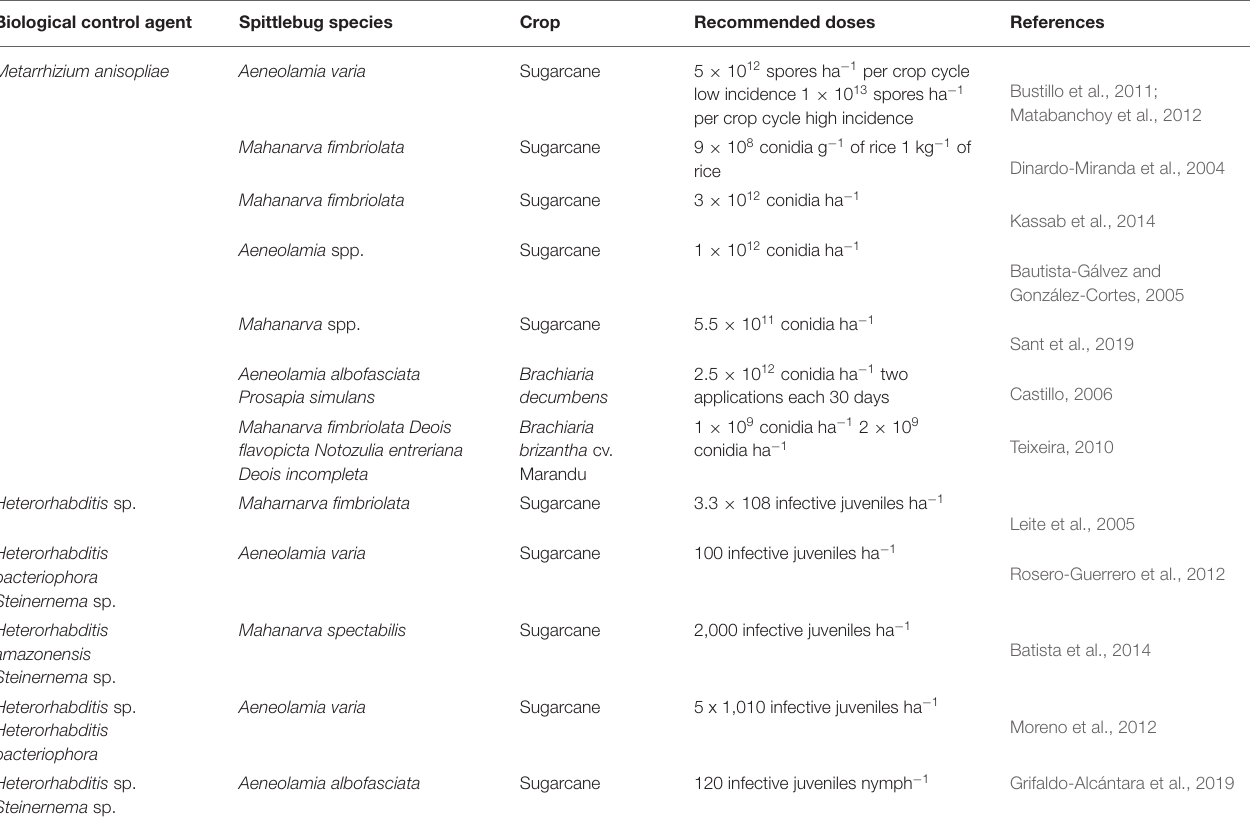
TABLE 4 | Different recommended doses of entomopathogenic fungi Metarrhizium anisopliae and nematodes in sugarcane and grasses to control spittlebugs. Biological control